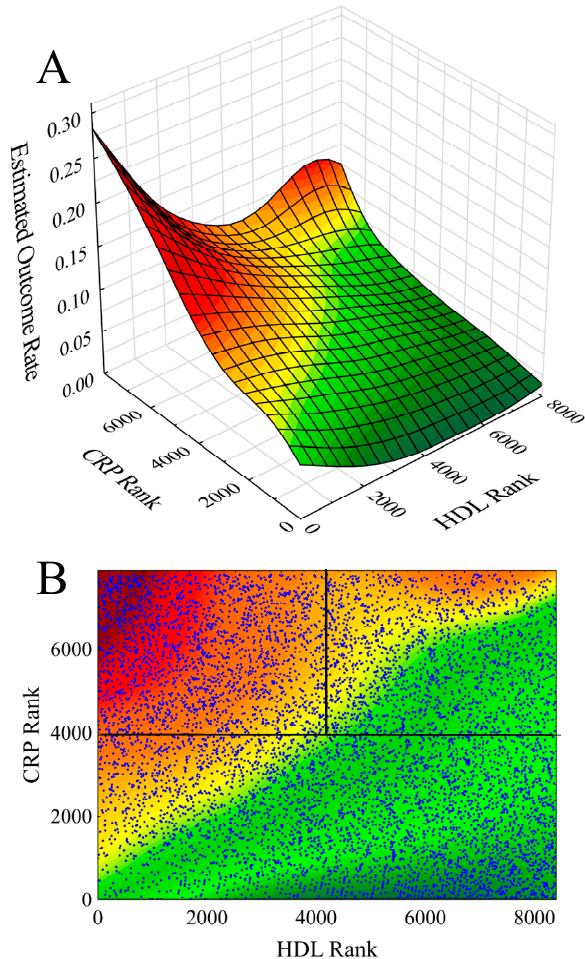
Figure 1. Cardiovascular event rates as a function of high-density lipoprotein (HDL) rank and C-reactive protein (CRP) rank given: ( A ) as a surface plot and ( B ) as a contour plot. The contour plot demarcates a low risk population (LR) characterized by lower CRP, a high-risk population (HR1) characterized by low HDL and high CRP, and another high-risk population (HR2) characterized by high HDL and high CRP.